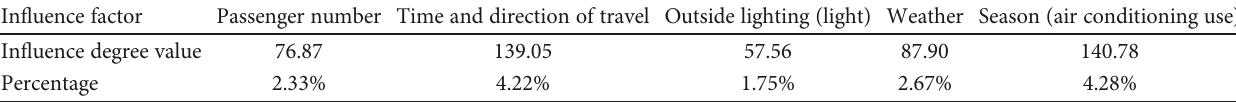
Table 5: The in fl uence degree of energy consumption in fl uence factors